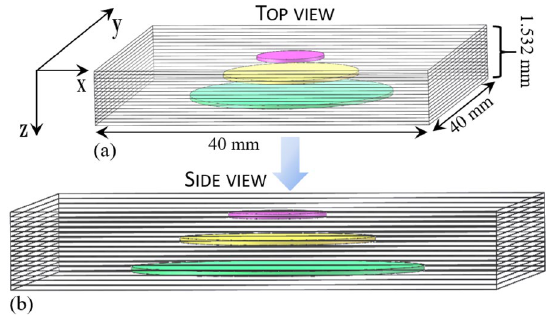
Figure 4 A schematic representation showing the sample preparation process of the multi-delaminated GFRP specimens. Note that the dummy sample is manufactured in the same way but does not have any